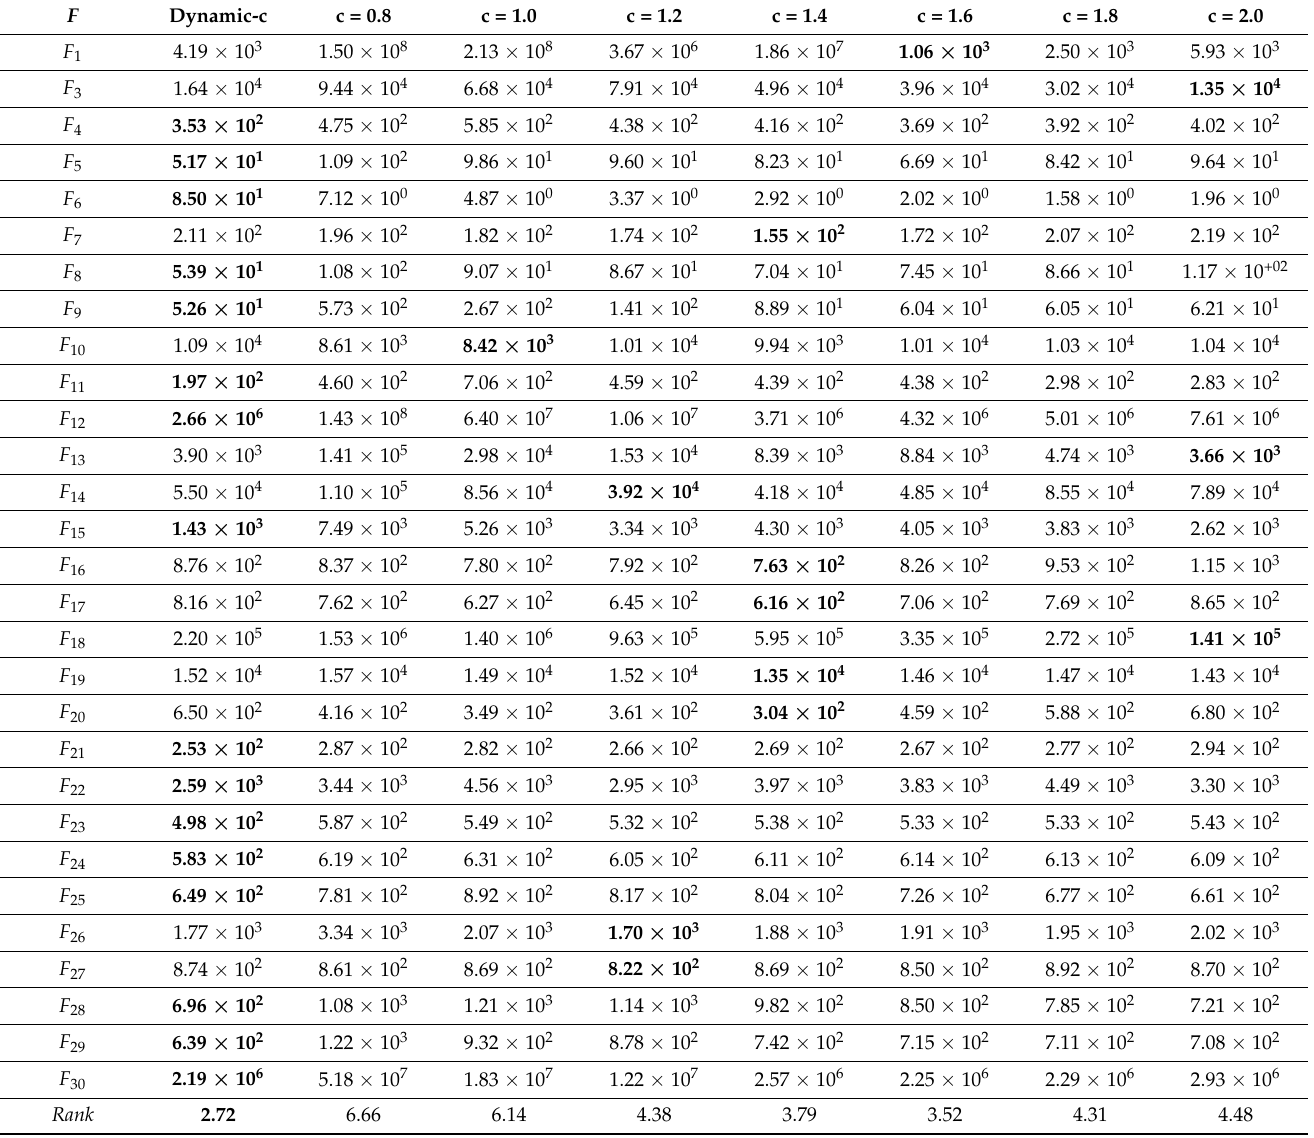
Table 9. Comparison results between PCLPSO with and without the dynamic strategy for c on the 50- D CEC 2017 benchmark